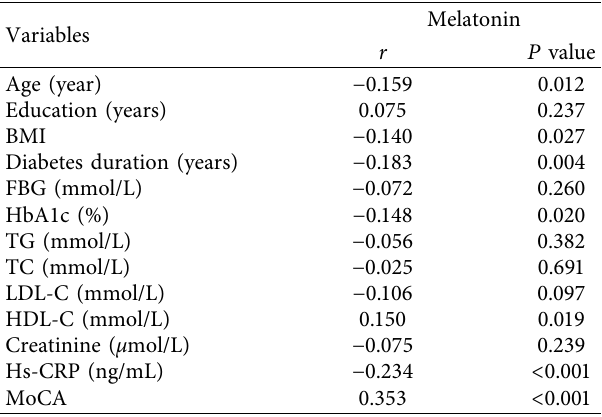
Figure 1: Serum levels of melatonin in diabetic patients with and without MCI. All data are expressed as medians and interquartile ranges (IQR). Mann–Whitney U tests were performed to compare the differences between groups. MCI: mild cognitive impairment. Table 3: The correlations of serum melatonin level with other clinical indicators and cognitive performances in T2DM